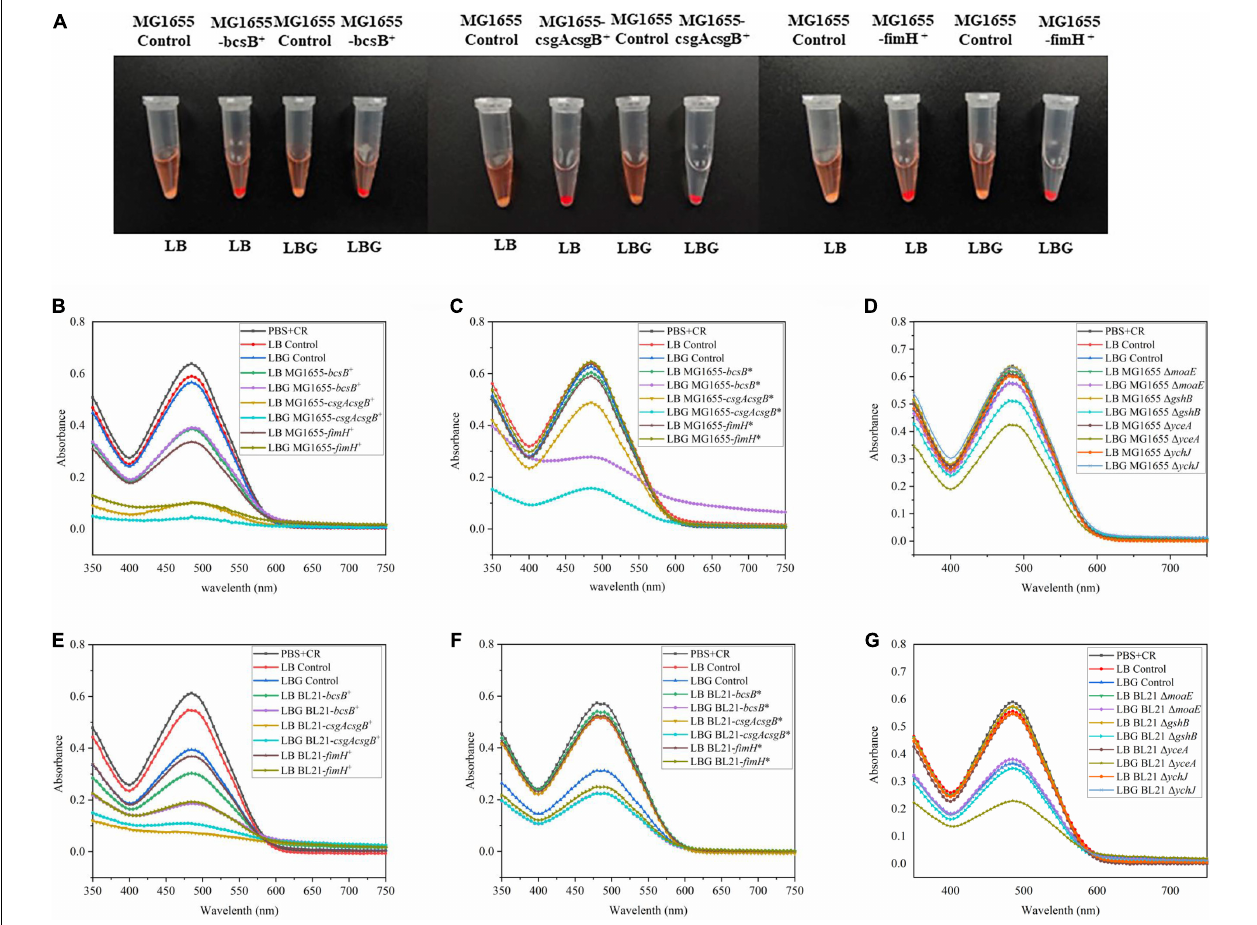
FIGURE 3 | CR binding assay for certain biofilm matrix components. (A) CR adsorption by MG1655 cells overexpressing biofilm related genes grown in LB or LBG medium. (B–G) Residual amount of CR in the supernatant after adsorption with different recombinants cells, measured as absorbance at 485 nm [see section “Congo Red (CR) Assay” for experimental details].